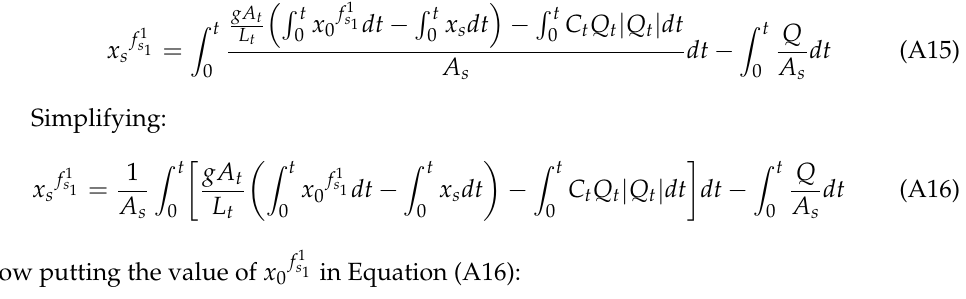
Figure 1. Three-pond hydraulic system.